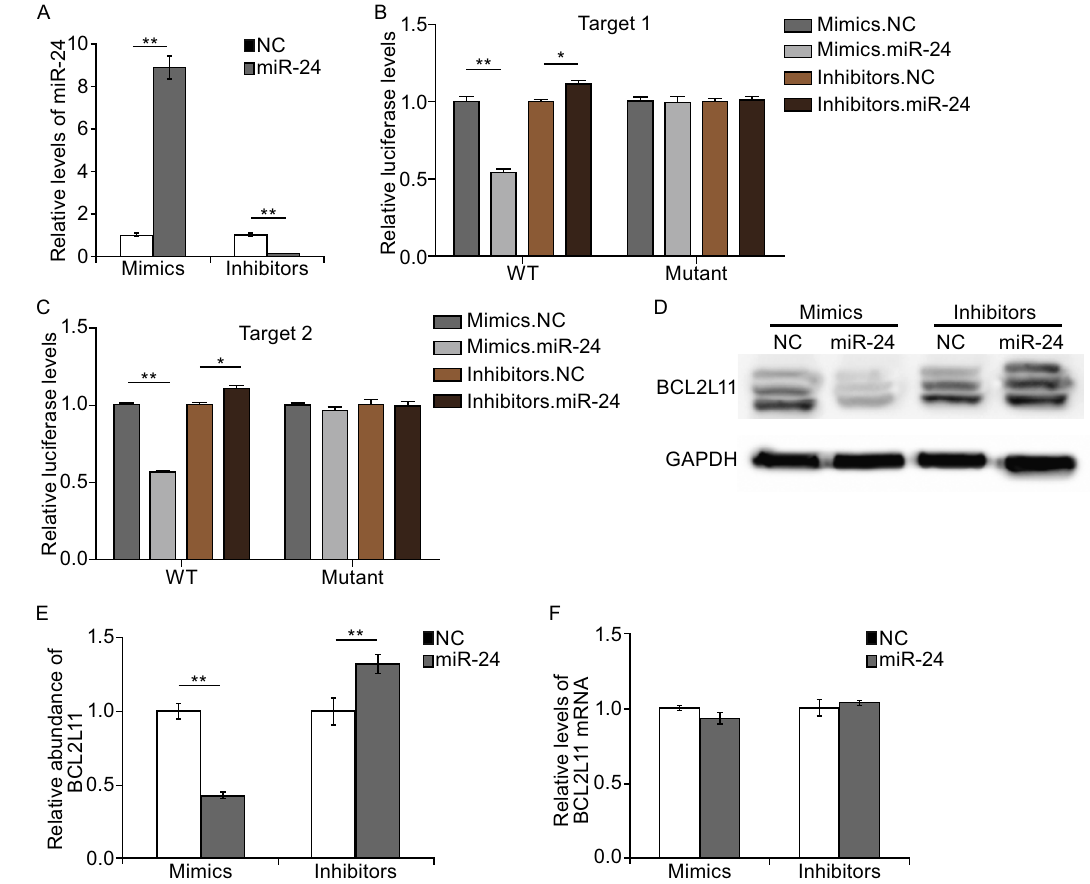
Figure 2. MiR-24 regulates BCL2L11 expression in gastric cancer cells. (A) Quantitative RT-PCR analysis of miR-24 levels in SGC7901 cells transfected with mimics or inhibitors. (B and C) Direct recognition of BCL2L11 by miR-24. HEK293T cells were co- transfected with fi re fl y luciferase reporters containing either WT or mutant BCL2L11 3 ′ UTR with miR-24 mimics and inhibitors. The interaction between miR-24 and target 1 (B) or target 2 (C) was shown respectively. (D) The suppression of BCL2L11 expression by miR-24 in SGC7901 cells. (E) Quantitative analysis of (D). (F) Quantitative RT-PCR analysis of BCL2L11 mRNA expression in SGC7901 cells. ** indicates P < 0.01; * indicates P <